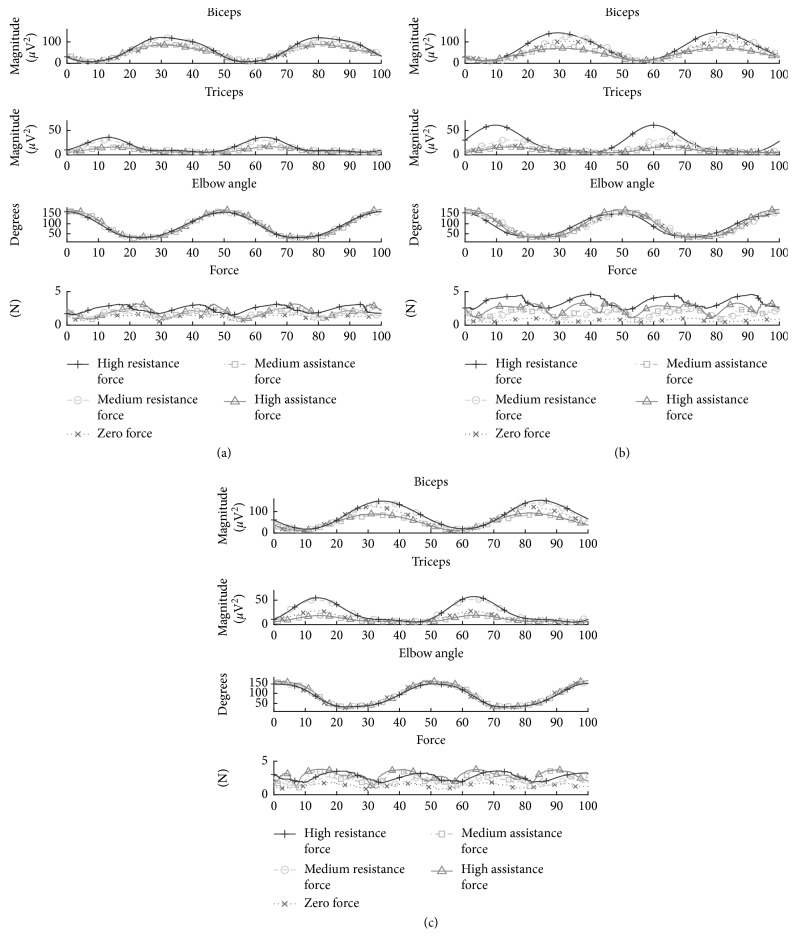
Postprocessed sEMG signals of the monitored muscular activity from the BB and TBL muscles of a healthy subject. The curves represent the median activations of different working load profiles of 3 force levels (resistance, zero or no force, assistance) × 3 movement's speed levels: (a) low, (b) medium, and (c) high.